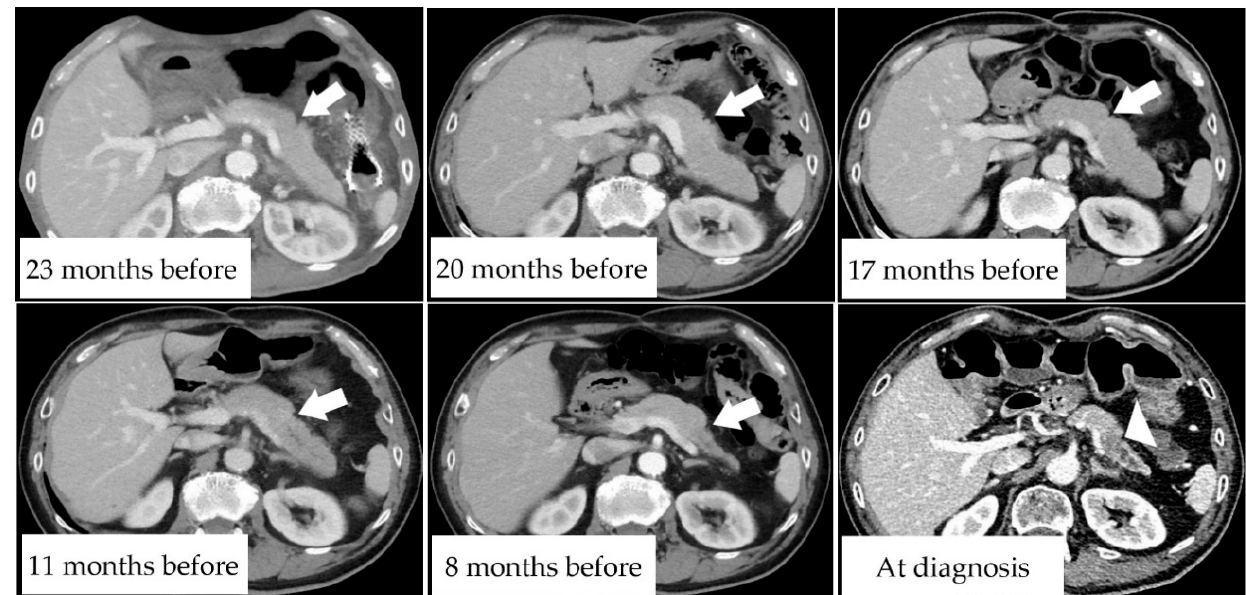
Figure 2. A man in his early 70s with pancreatic tail ductal adenocarcinoma (PDAC). Pre-diagnostic CT scans at 23, 20, 17, 11, and 8 months before PDAC diagnosis showing temporal changes in the pancreatic tail. White arrows indicate focal pancreatic atrophy, and the white arrowhead indicates invasive pancreatic ductal adenocarcinoma.